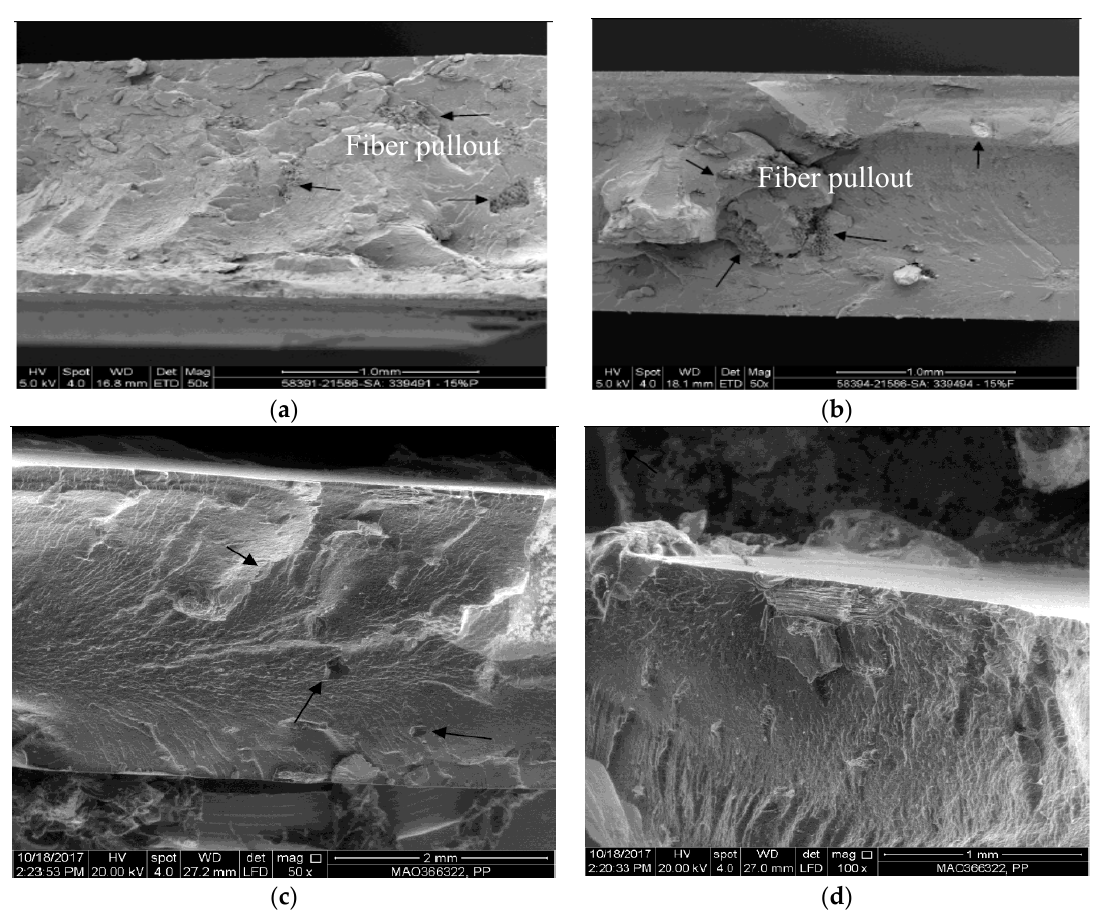
Figure 8. SEM images of fractured surfaces of HPP composite with 15% loading of DPF. ( a ) Untreated powder; ( b ) untreated fiber; ( c ) treated powder; ( d ) treated fiber.